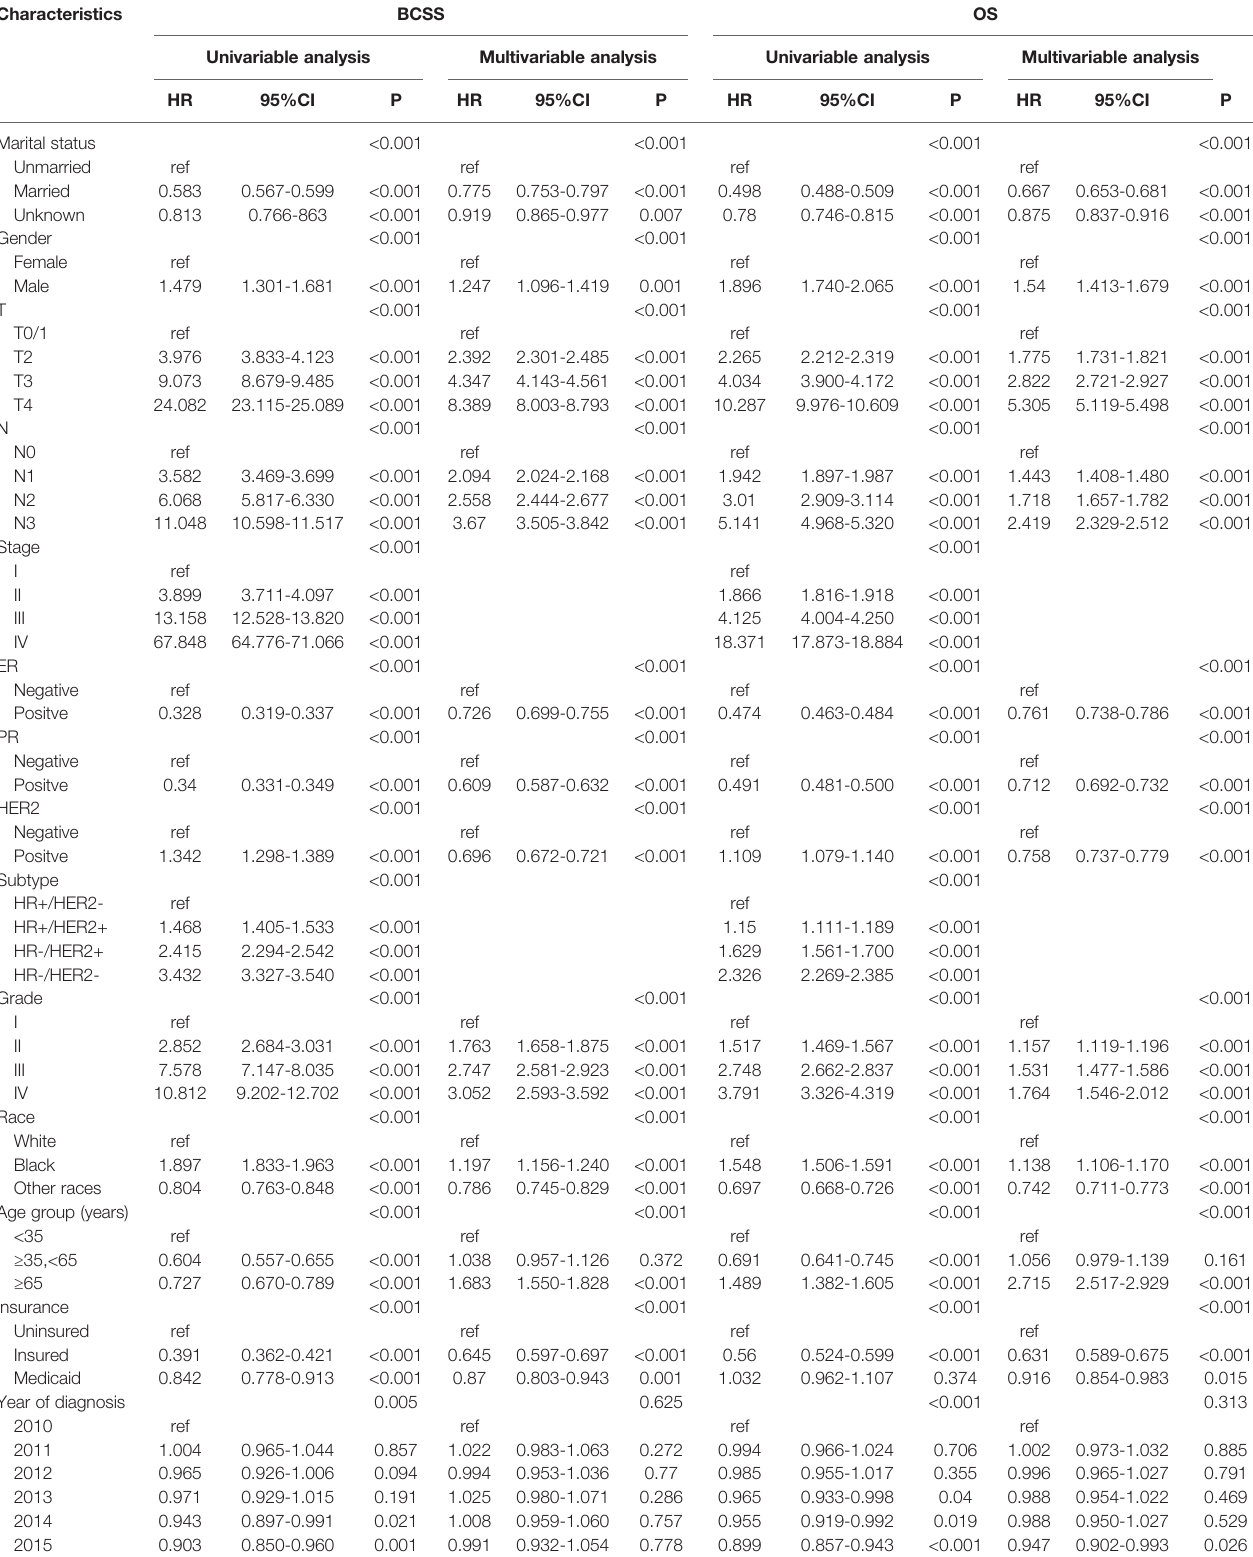
TABLE 2 | Univariable and multivariable analyses regarding BCSS and